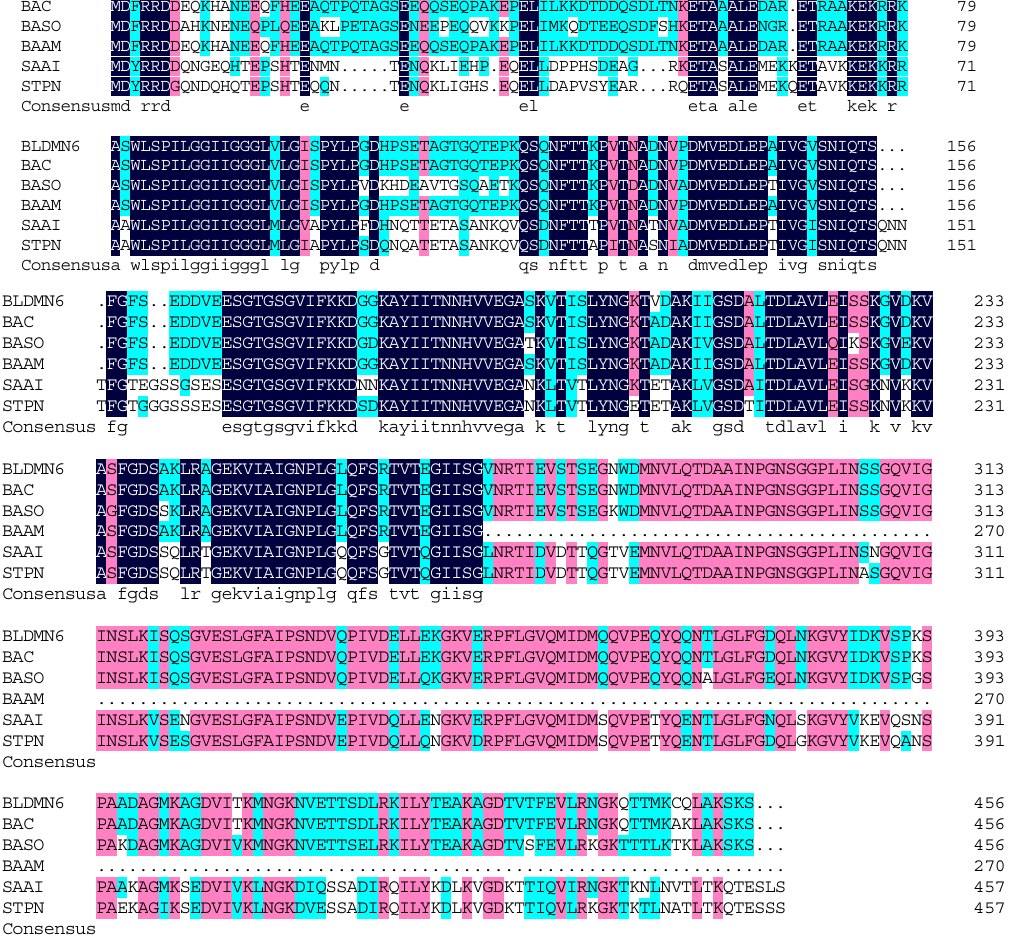
from B. licheniformis DMN6; BAC, the putative serine protease from Bacillus genus (WP_003185101.1); BASO, the putative serine protease from B. sonorensis (WP_029418466.1); BAAM, the putative serine protease from B. amyloliquefaciens (WP_044803775.1); SAAI, the putative serine protease from Salinibacillus aidingensis (WP_044159062.1); STPN, the serine protease HtrA from Streptococcus pneumoniae (CON63954.1). The different colors represent the different sequence identities. The black color represents the highest identity, the second is pink color and the last is light blue color.